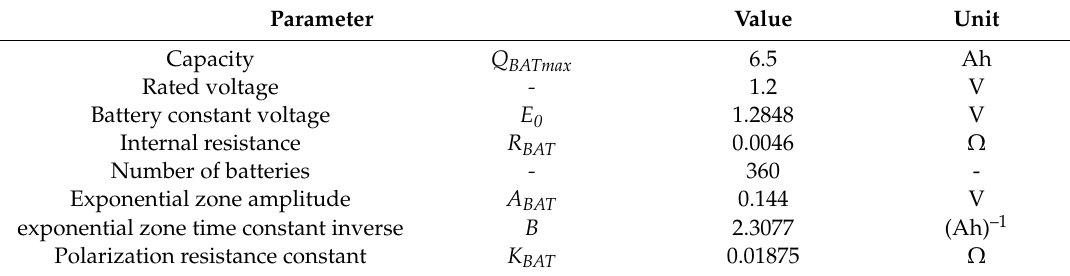
Table 8. Battery parameters